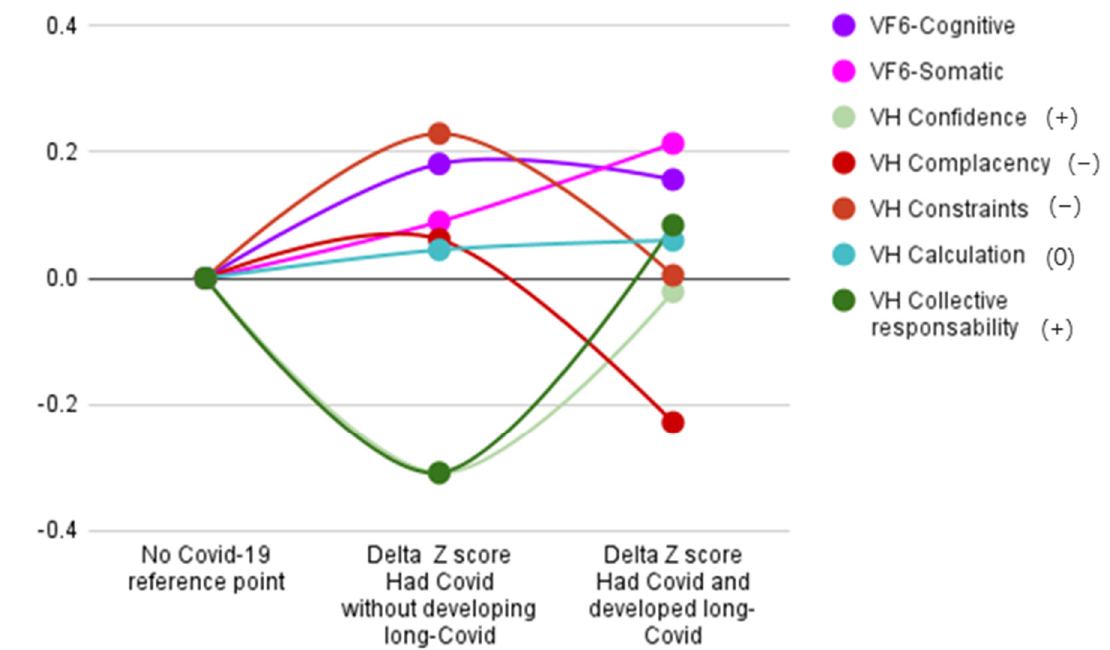
Figure 1. Standardized differences in vaccine hesitancy and vaccination fear between groups. Vaccine hesitancy (VH) dimensions marked with a plus symbol underline a positive opinion of vaccination, while VH dimensions marked with a minus sign are those related to a negative opinion of vaccination. Zero (0) was used for the calculation, since no clear interpretation could be drawn for that dimension.